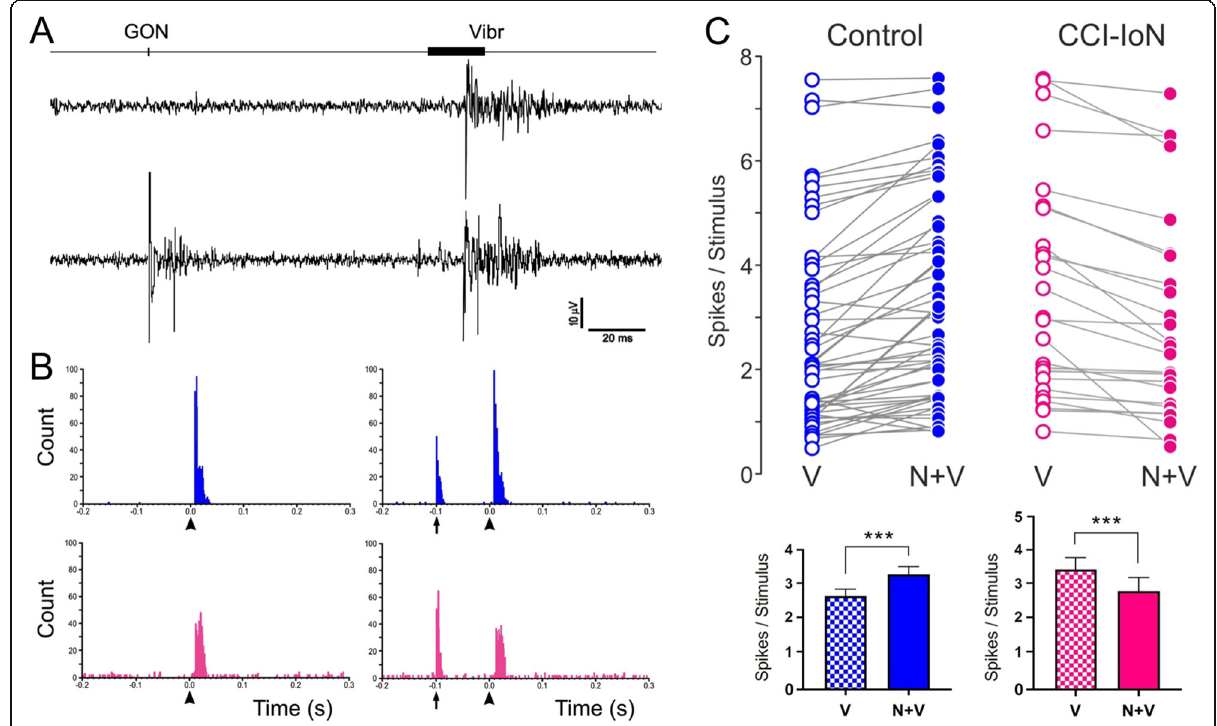
Fig. 4 Effect of GON stimulation on vibrissal responses in control (blue) and CCI-IoN (magenta) animals. ( a ) An example of raw recordings during vibrissal stimulation alone (upper trace) or preceded by GON stimulation (lower trace). ( b ) Representative PSTHs in a control case (upper plot) and a CCI-IoN case (lower plot). Plots on the left show the response to vibrissal stimulation (arrowheads) alone. On the right, responses to vibrissal stimulation (arrowheads) when preceded by GON stimulation (vertical arrow) are illustrated. In the control case (top) GON stimulation facilitated vibrissal response, whereas the opposite occurred in the CCI-IoN. ( c ) Top, same-case comparisons between vibrissal responses alone (V, empty circles) and when preceded by GON stimulation (N + V, 100 ms delay; filled circles) in control (blue traces) and CCI-IoN animals (red traces). Bottom, mean (+sem) vibrissal responses from the data above. GON stimulation facilitated vibrissal response in control animals but inhibited vibrissal responses in CCI-IoN animals. *** p <